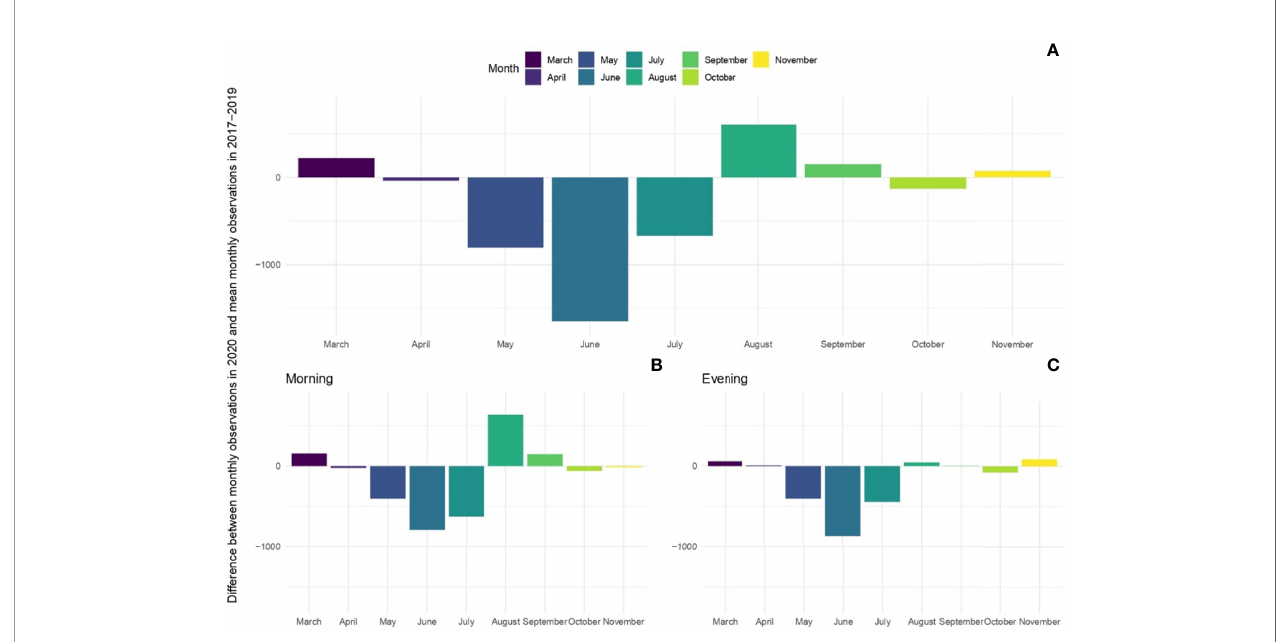
FIGURE 5 | Difference in monthly detections between 2020 and the 2017-2019 period. Negative values represent a decrease in number of detections in all images (A) , only for morning images 7:00 am to 8:00 am (B) , only for evening images taken from 7:00 pm to 7:45 pm (C)